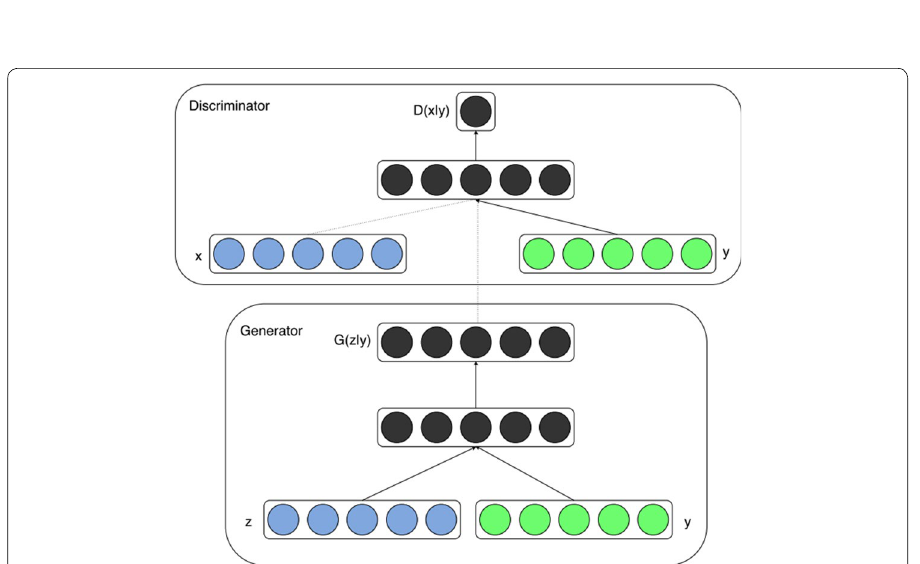
Fig. 22 Illustration from Mirza and Osindero [95] showing how the conditional y vector is integrated into the GAN